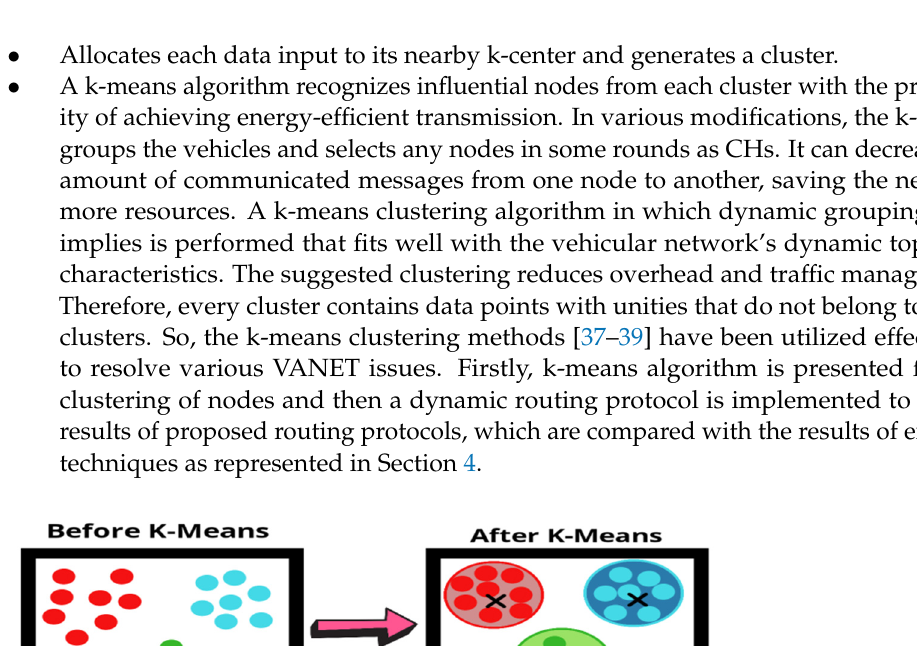
Figure 4. Support vector machine approach . 4. Mathematical Analysis for Proposed Protocol The operation of the proposed protocol is defined below: 1.